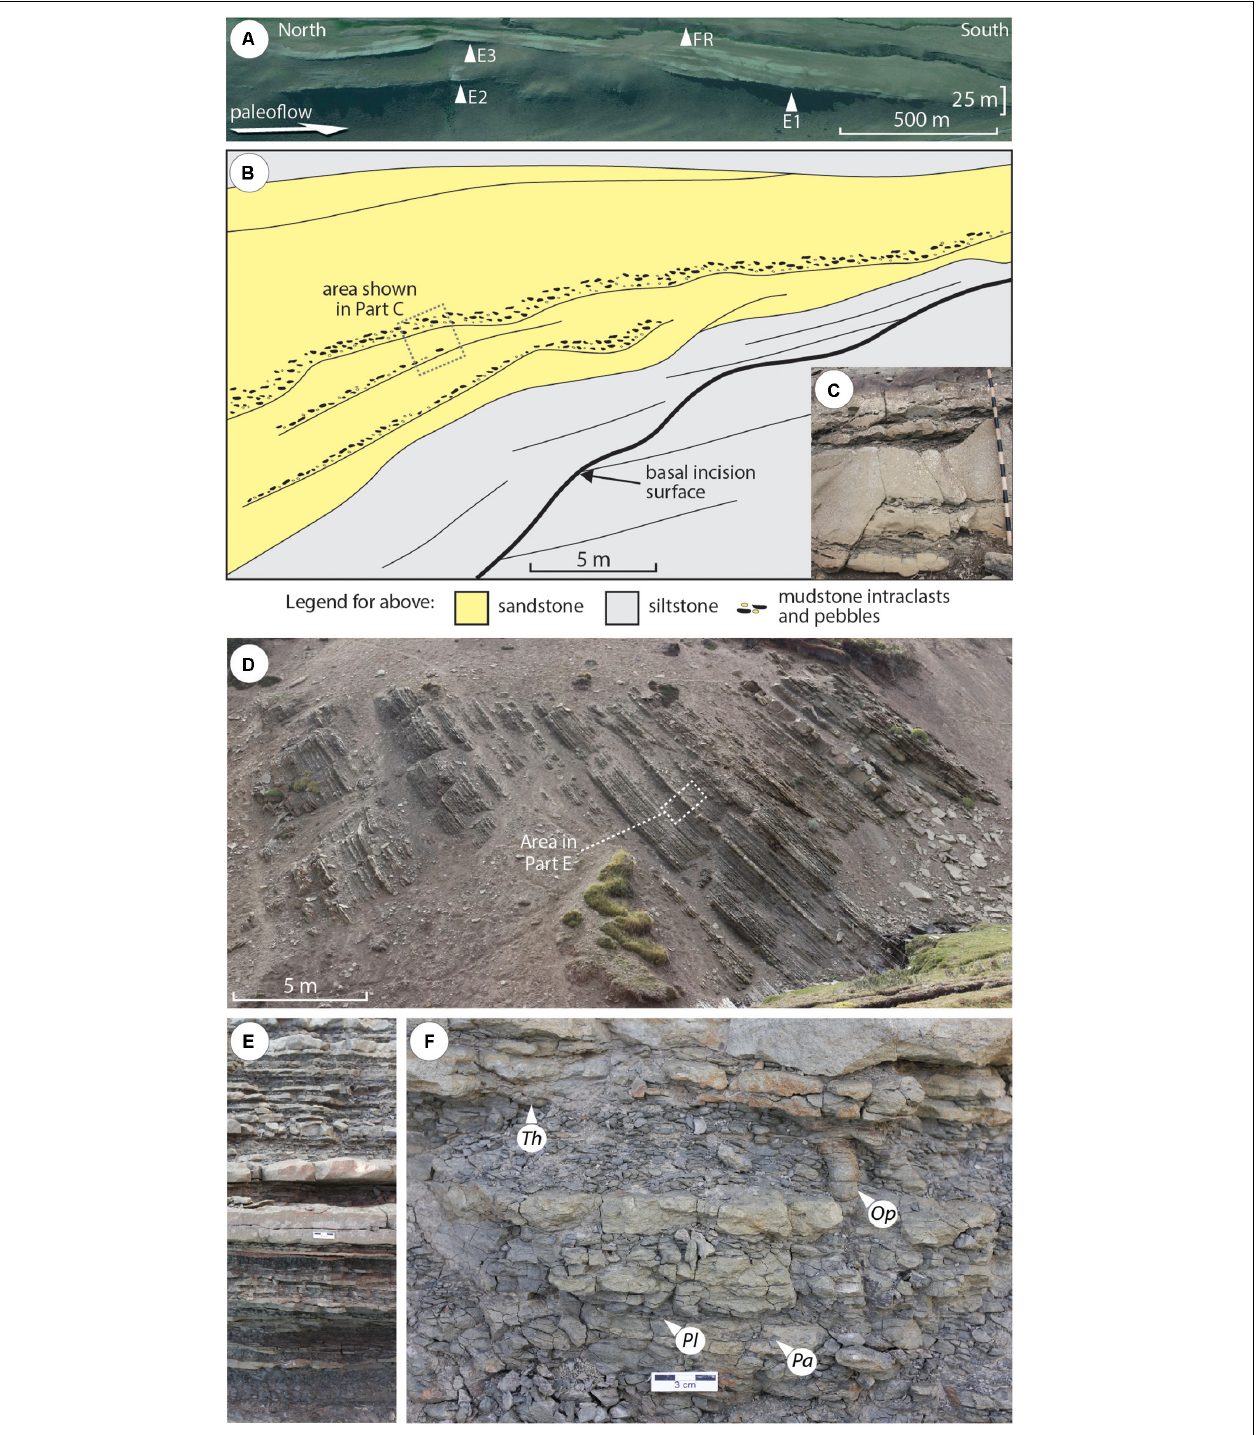
FIGURE 6 | Figueroa shelf-margin stratigraphic architecture and facies. (A) Depositional dip-oriented perspective satellite image featuring discontinuously resistant, along-slope channel sandstone deposits (white arrows; locations E1-E3 and FR in Figures 2C , 3 ) (image data from Google, Landsat, Copernicus, 2016, http://google.com/earth/index.html). (B) Outcrop sketch of channel fill with the basal incision surface draped by mudstone-dominated turbidites, and subsequently overlain by amalgamated thick-bedded sandstone deposits (F3). (C) Variably amalgamated thick- to thin-bedded turbidites with common mudstone clasts; Jacob staff is 1.5 m in length. (D) Interbedded tabular, normally graded sandstone (F4) and carbonaceous mudstone (F1). (E) Interbedded tabular normally graded fine- to medium-grained sandstone (F4) and mudstone (F1) [location in (D) ]. Scale bar in middle of photo is 3 cm long. (F) Bioturbated mudstone (F1) and fine- to medium-grained sandstone (F4) with rare Thalassinoides (Th), Ophiomorpha (Op), Palaeophycus (Pa) and Planolites (Pl). All outcrop locations are denoted by Figure number in Figures 2C , 3 .